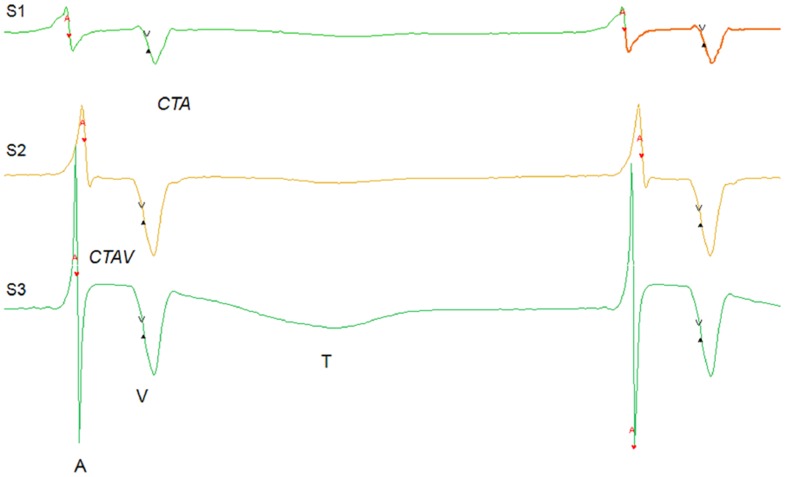
An example of recorded atrial electrogram (AEG): three channels (S1: superolateral right atrium. S2: inferior right atrium; S3: superior left atrium.) AEG in 2 consecutive normal sinus beats.The atrial (A) and ventricular (V) activations are indicated, as well as the ventricular T wave (T). AA, CTA and CTAV are also indicated.